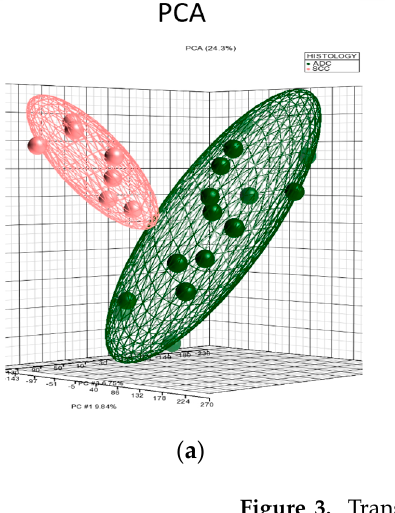
Figure 2. Mutational status determination of EGFR and KRAS genes using BEAMing technology. A mutant allelic fraction (MAF) of 55.33% for the EGFR exon 19 deletion was detected in exosomal DNA from the H1650 cell line ( left panel), whereas a mutant fraction of 79.12% was present in SW900 exosomal DNA for a KRAS mutation (exon 2, codon 12–13) ( right panel).